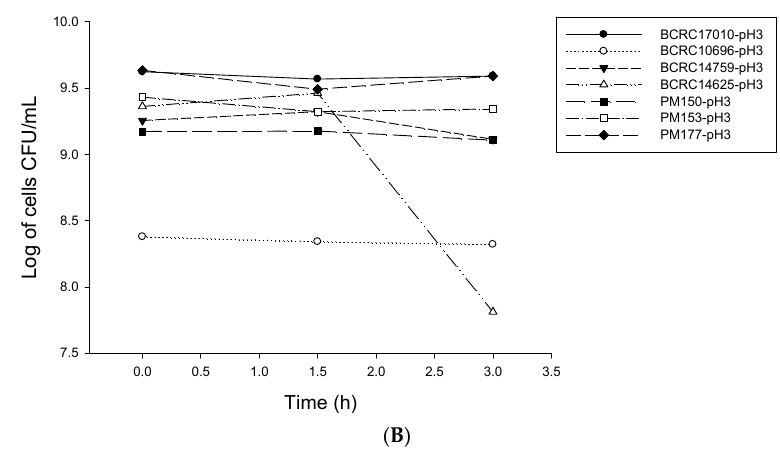
Figure 1. Survival of lactic acid bacteria in simulated gastric juice ( A ) pH 2.0 ( B ) pH 3.0.